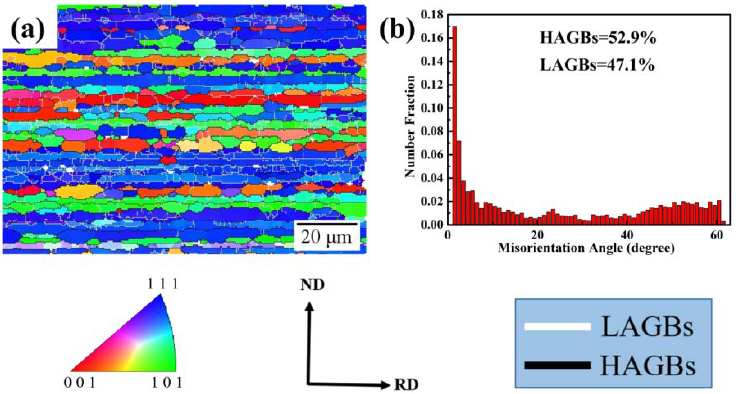
Figure 3. EBSD maps of the hot rolled Al-5Mg-2Li-0.2Sc-0.12Zr alloy: ( a ) IPF map, ( b ) misorienta- angle distribution tion angle distribution histogram.